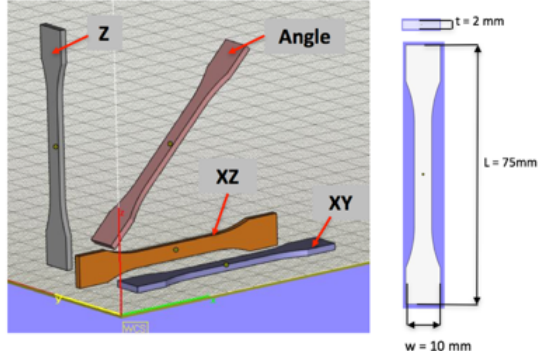
Figure 3. Schematic visualization of parts’ orientations and dimensional features (where t —thickness, w —width and L